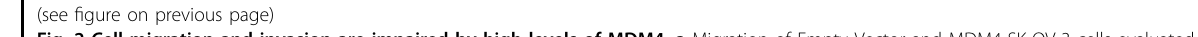
Fig. 2 Cell migration and invasion are impaired by high levels of MDM4. a Migration of Empty Vector and MDM4-SK-OV-3 cells evaluated through wound-healing assay. Pictures were taken at time 0 and 24 h after the scratch. Pictures are representative of four biological replicates ( n = 4, two-tailed Student ’ s t test p < 0.0001); scale bar = 200 μ M. b Representative time-lapse micrographs of cell velocity of a mixed population of Empty Vector and MDM4-SK-OV-3 cells labeled with GFP or mCherry, respectively, in a wound-healing migration assay ( n = 331 cells for Empty Vector and n = 177 cells for MDM4, two-tailed Student ’ s t test, p < 0,0001); scale bar = 200 μ M. c Representative WB of MDM4 levels following overexpression in OVCAR-3 cells. d Micrographs of transwell cell invasion assay through matrigel by Empty Vector or MDM4- OVCAR-3 cells scale bar = 50 μ M. Right panel shows the quanti fi cation (mean ± SD, n = 3, two-tailed Student ’ s t test, p < 0.0001). e Representative images of invading Empty Vector- or MDM4-SK-OV-3 multicellular tumor spheroids (MCTSs) at time 0 and after 6 days of culture. Lower panel, spheroid diameter extrapolated by spheroid area calculated by Visual ImageJ and correlated to t0 area set to 1 ( n = 7, two-tailed Student t test, ** p = 0.0041 *** p < 0.0001). f Representative time- lapse images of invading Empty Vector- or MDM4-SK-OV-3 MCTSs. The invading area was calculated as follows: total MCTS area at 48 h minus MCTS body area at t0 ( n = 5, Two-way ANOVA for multiple comparisons, p = 0.001); scale bar = 100 μ